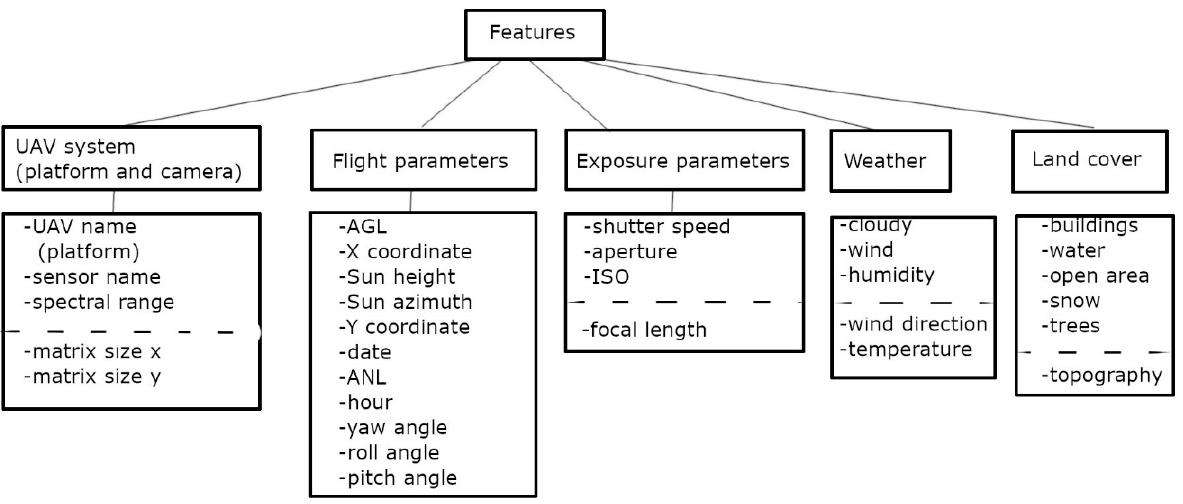
Figure 6. Feature importance tree.